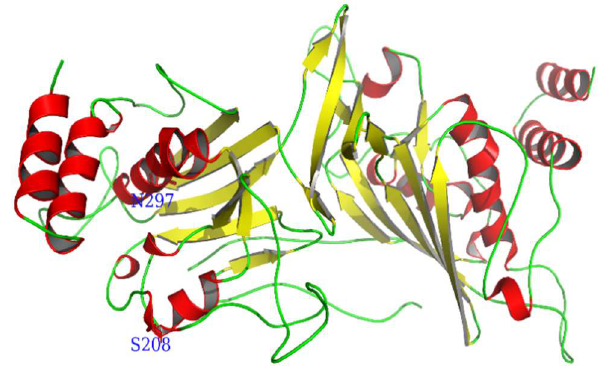
Figure 2. Analyses of the amino acid sequence of CmdsRNase (dsRNase from C. medinalis ). ( a ) Schematic diagram of the domain of CmdsRNase. The red box, blue box, and blue line represent the signal peptide, endonuclease_NS domain, and linker region, respectively. ( b ) Multiple sequence alignment of dsRNases from different insect species: CmdsRNase ( C. medinalis ), BmdsRNase ( B. mori , BAF33251.1), SgdsRNase ( S. gregaria , AHN55088.1), LmdsRNase ( L. migratoria , ARW74135.1), OndsRNase ( Ostrinia nubilalis , MT524712.1), and McdsRNase ( Mamestra configurata , HM357845.1). Blue inverted triangles represent active sites of six key amino acid residues, the yellow triangle indicates Mg 2+ -binding sites, and black triangles mark substrate-binding sites.